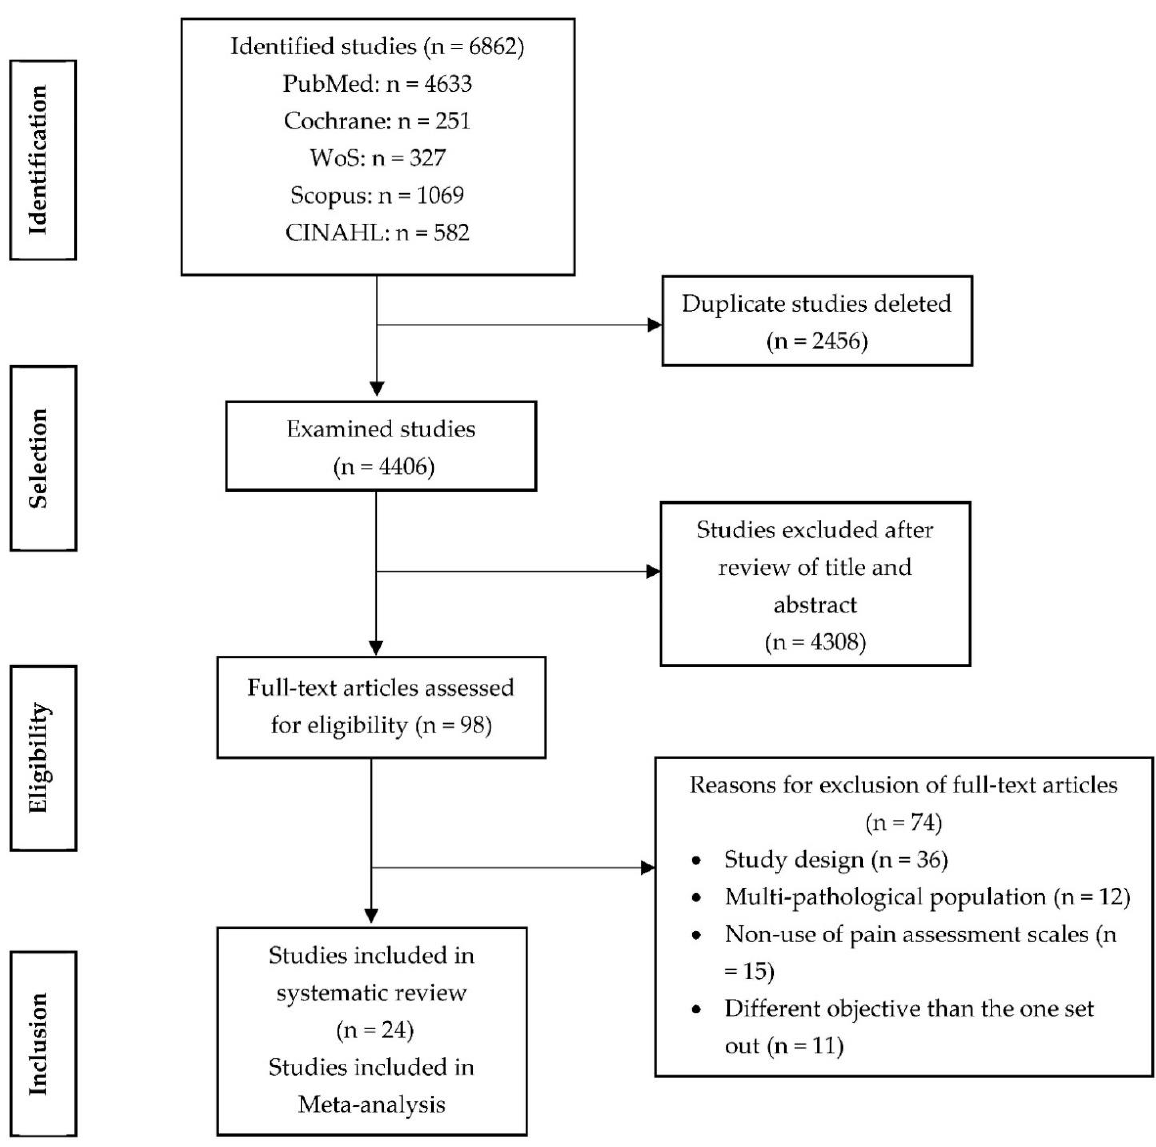
Figure 1. Flow chart for study selection.